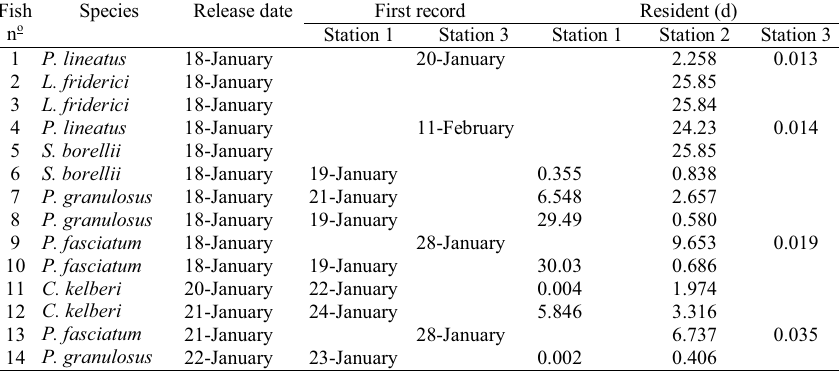
Fig. 4. Movements of Prochilodus lineatus (fish n o 1 and 4) and Pseudoplatystoma fasciatum (fish n o 9, 10 and 13) in the lateral channel located near Itaipu Dam (detections in the fixed stations, in number of hours post-release, are shown in the white circles). the release site for the entire period that Station 2 was opera- tional. These individuals were the smallest of the tagged fish (35-36 cm in total length and only 550 g). Table 2. Release dates and tracking results for each radio-tagged fish. Resident (d) = residence time in each fixed station expressed in number of